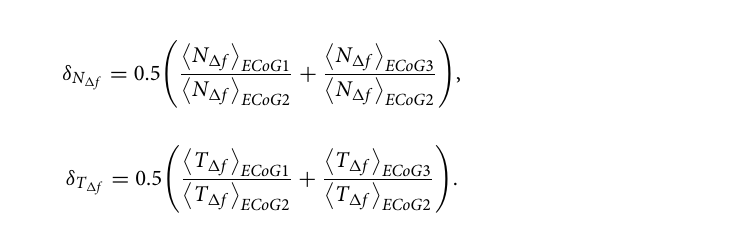
(1) for wakefulness and sleep states, respectively, f